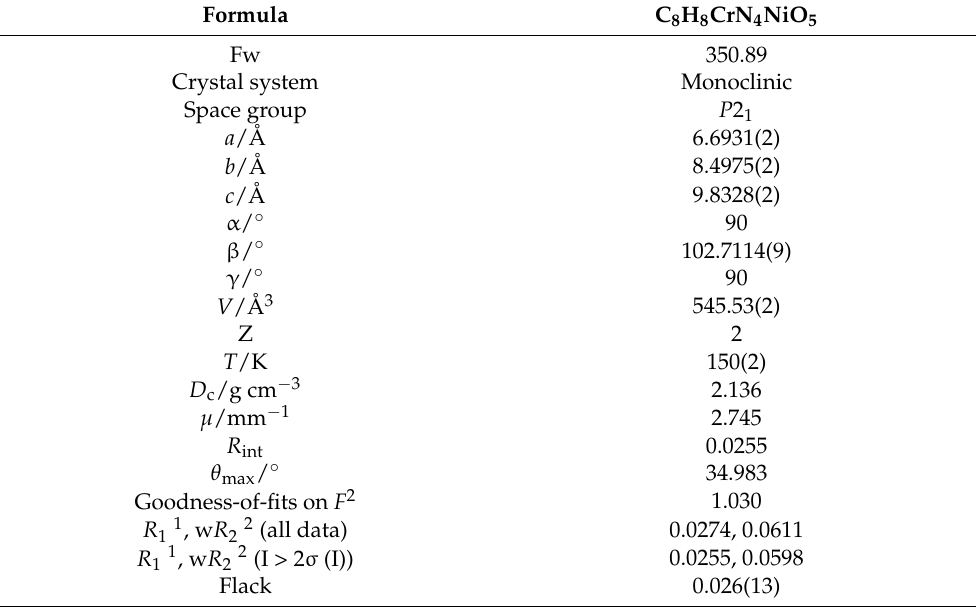
Table 1. Crystallographic data for compound 1 .